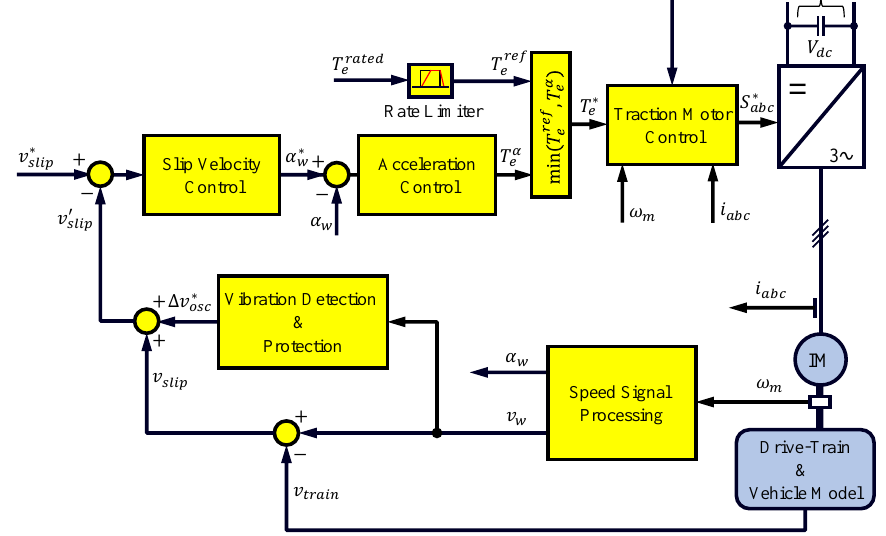
Figure 8. Overall slip control scheme with torsional vibration